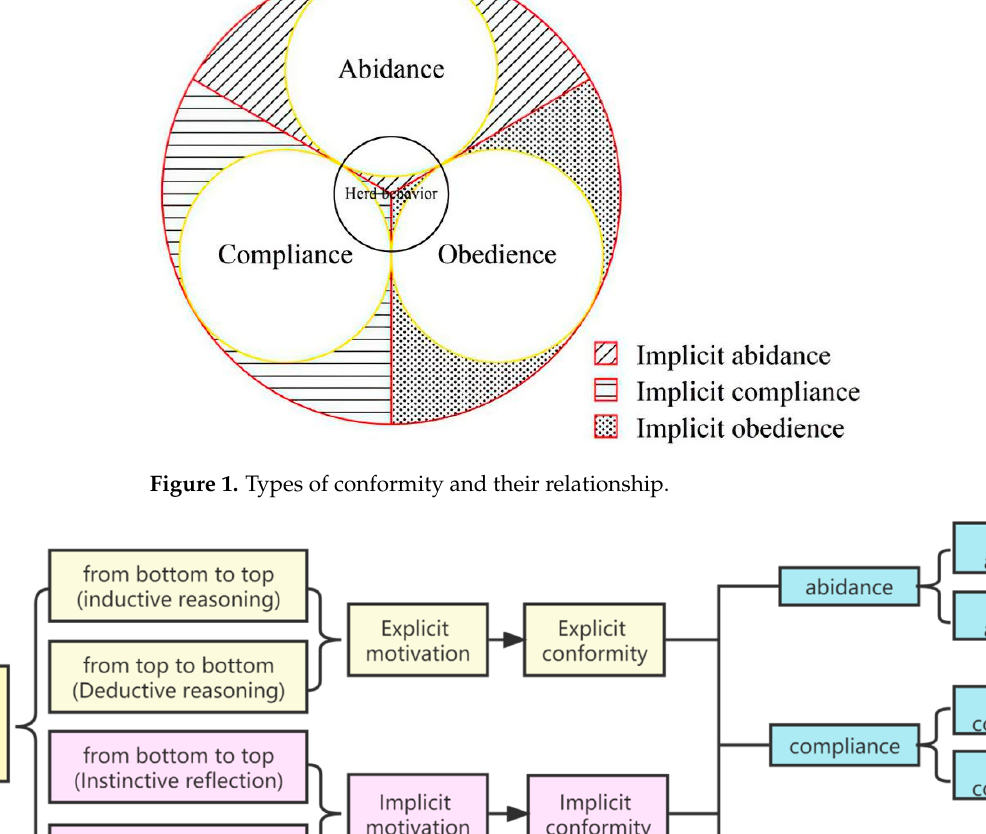
digger circle represent abidance, compliance, and obedience. The small circle passing through the tangent point of the inscribed circle represents conformity in a narrow sense, (i.e., herd behavior). Herd behavior, in its narrow sense refers to conformity. The shaded areas in the figure represent implicit conformity (including three types: implicit abidance, implicit compliance, and implicit